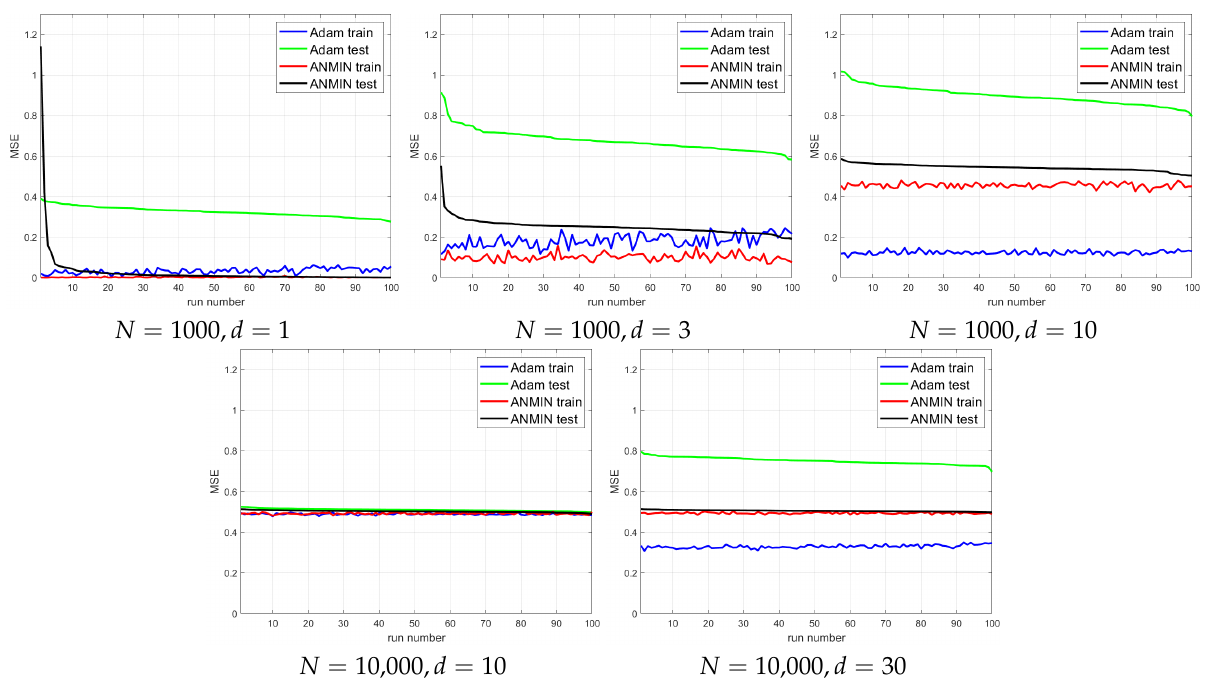
Figure 8. Simulation experiments. Final train and test MSEs obtained by the Adam and ANMIN over the 100 runs, sorted in decreasing order of the test MSE.